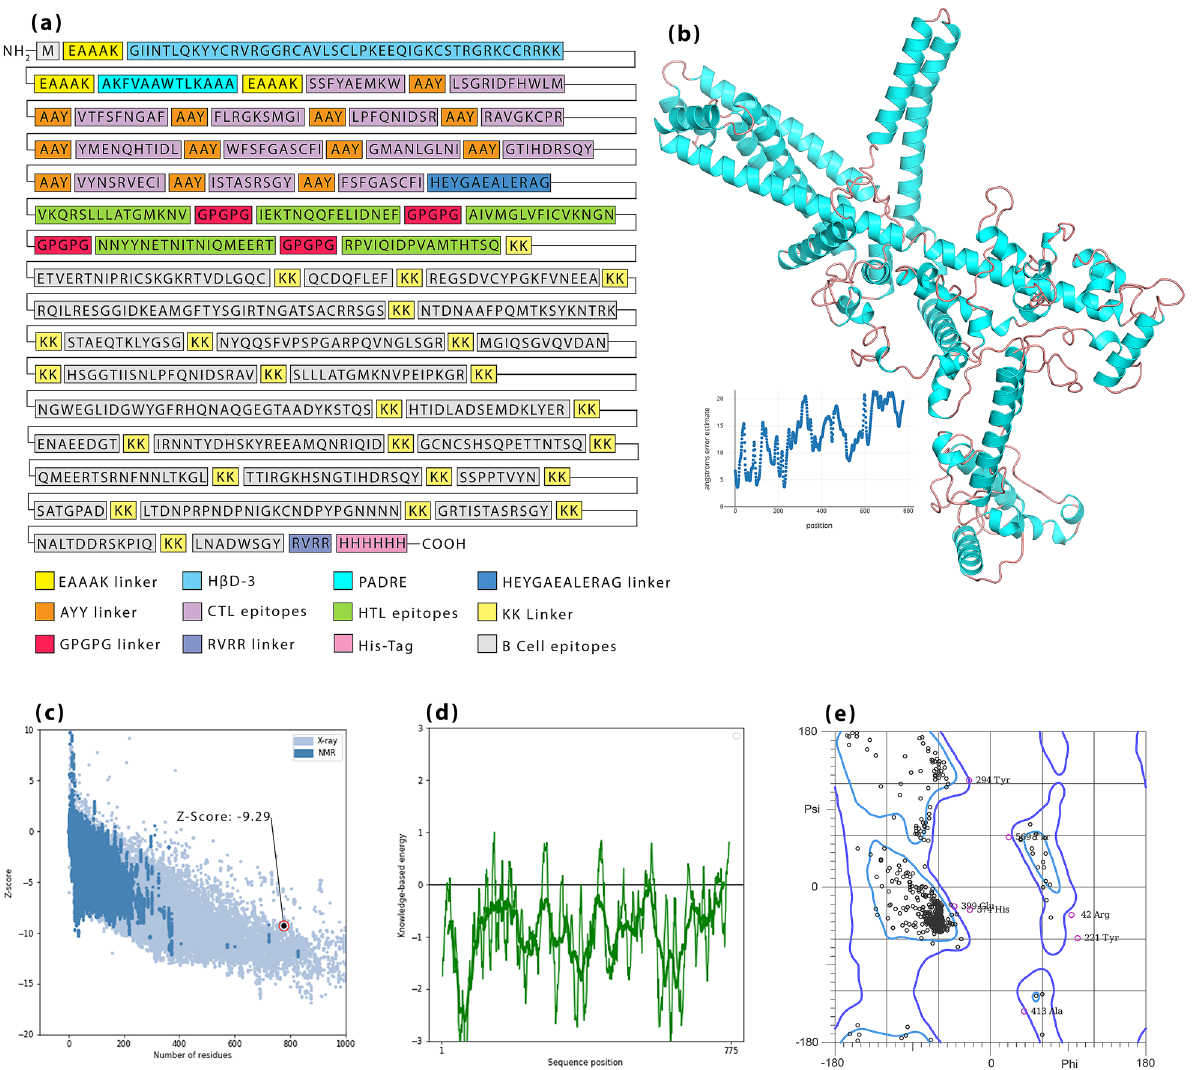
Figure 5. ( a ) Representation of H7N9vac construct schematic including linkers, adjuvants, CTL and HTL epitopes. EAAAK linkers connect the adjuvants, AAY linkers connect CTL epitopes, HEYGAEALERAG linker connects last CTL epitope to first HTL epitope, GPGPG linkers connect HTL epitope and RVRR linker connects Histidine-Tag to final construct. ( b ) Modeled 3D structure of H7N9vac. ( c ) Z-Score validation, ( d ) Local model quality and ( e ) Ramachandran plot related to vaccine 3D structure after refinement.